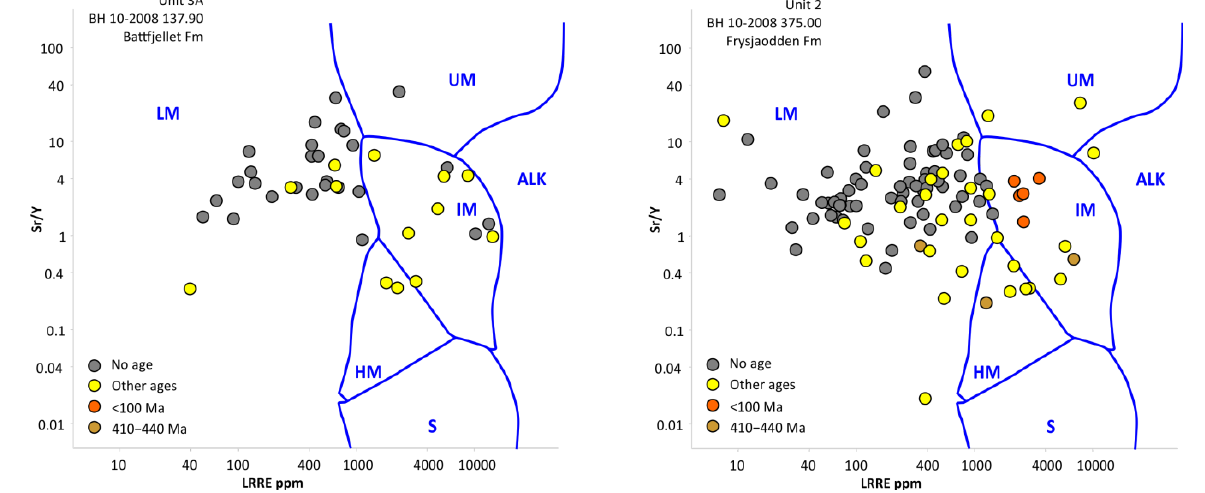
Figure 10. Apatite trace elemental data plotted on the discrimination diagrams from O’Sullivan, Chew, Kenny, Henrichs and Mulligan [80] where ALK = alkali-rich igneous rocks; IM = mafic I-type granitoids and mafic igneous rocks; LM = low- and medium-grade metamorphic and metasomatic; HM = partial-melts/leucosomes/high-grade metamorphic; S = S-type granitoids. Data from grains which also yielded reliable U-Pb age information are indicated.